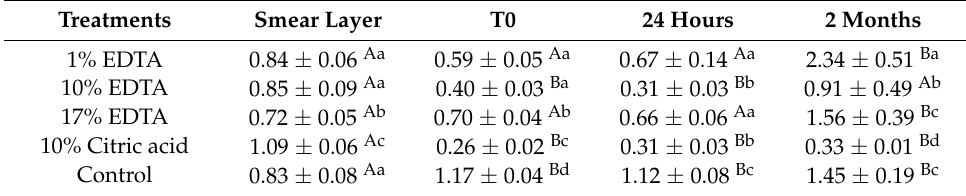
Figure 5. ESEM image, EDX spectra, and table of elements recorded on the dentin surface after sanding with abrasive paper ( a , b , c ), after washing with distilled water ( d , e , f ), and after immersion in SBF for 24 h ( g , h , i ) and two months ( l , m , n ). Table 2. Ca/N atomic ratios (mean ± standard deviation (SD)). In columns, identical superscript lowercase letters represent no statistical differences (two-way analysis of variance (ANOVA) followed by an RM Student–Newman–Keuls test) among tested solutions ( P ≥ 0.05). In the horizontal rows, identical superscript uppercase letters represent no statistical differences (one-way ANOVA for repeated measures followed by an RM Student–Newman–Keuls test) among evaluation times ( P ≥ 0.05).